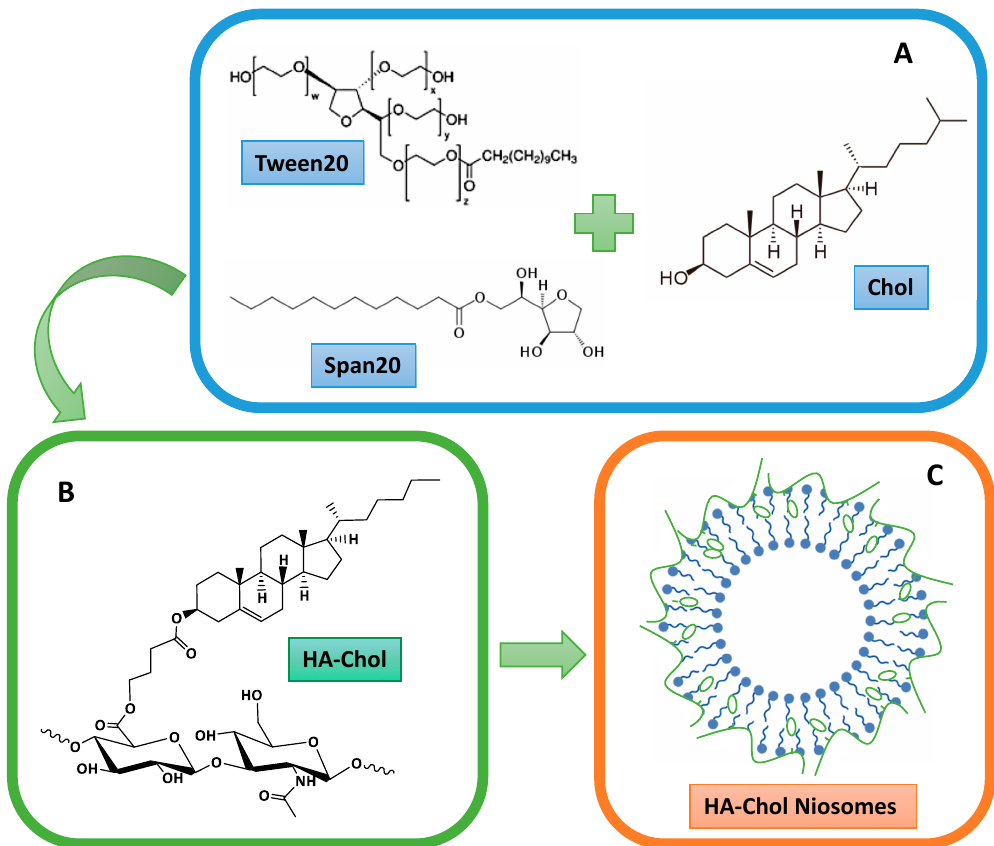
Figure 1. Scheme of HA-Chol-coated niosomal structure, where ( A ) shows the molecular structure of each niosomal compound; ( B ) shows the molecular structure of HA-Chol; ( C ) shows the hypothetical niosomal organization after the preparation.